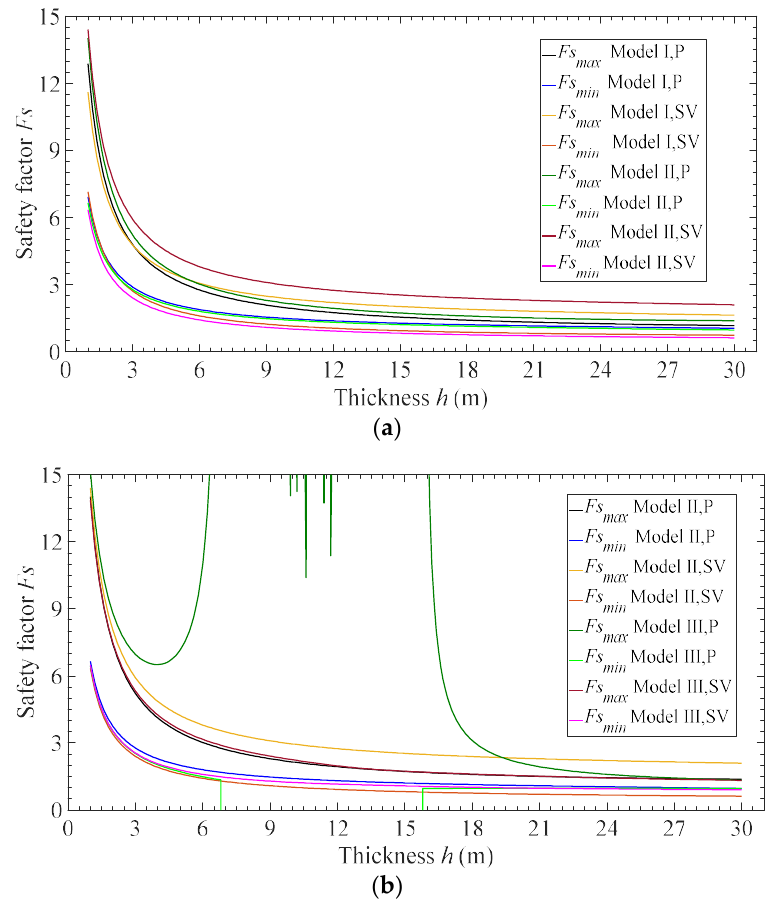
Figure 4. Instantaneous safety factor vs. thickness of slip body: ( a ) comparison between models I and II; ( b ) comparison between models II and III.